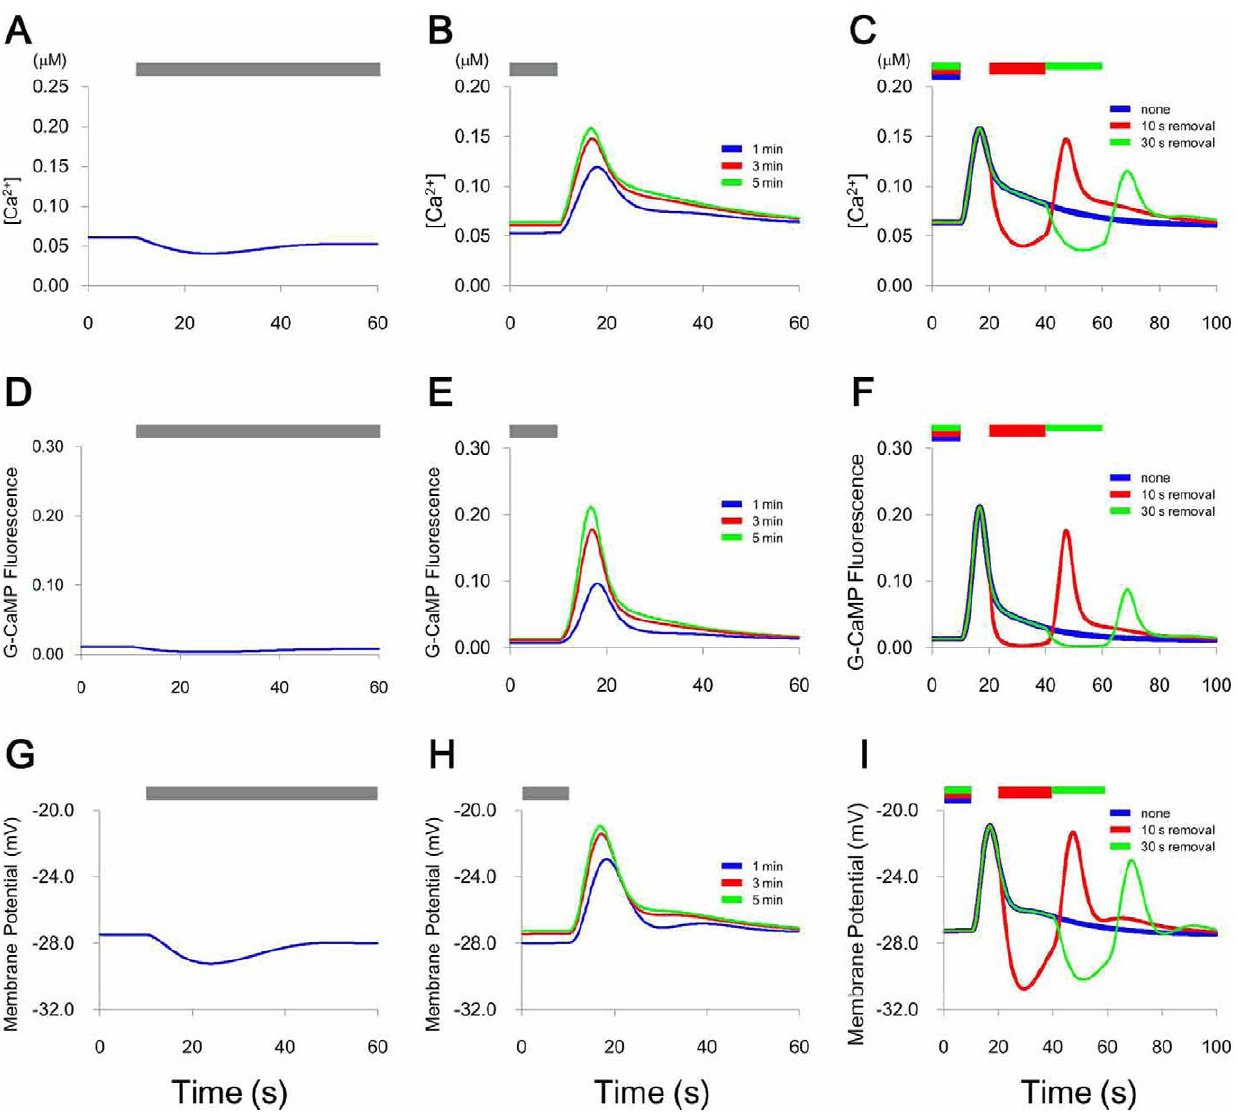
Figure 2. Change in [Ca 2 + ]. The bars indicate periods of stimulation. A. Addition of stimulus. B. Removal of stimulus. Duration of stimulus was 1, 3, or 5 min. C. After removal of the first 5-min stimulus, a second 20-s stimulus was applied 10 or 30 s later. D, E, F. G-CaMP fluorescence associated with A, B, C, respectively. G, H, I. Membrane potential associated with A, B, C, respectively.